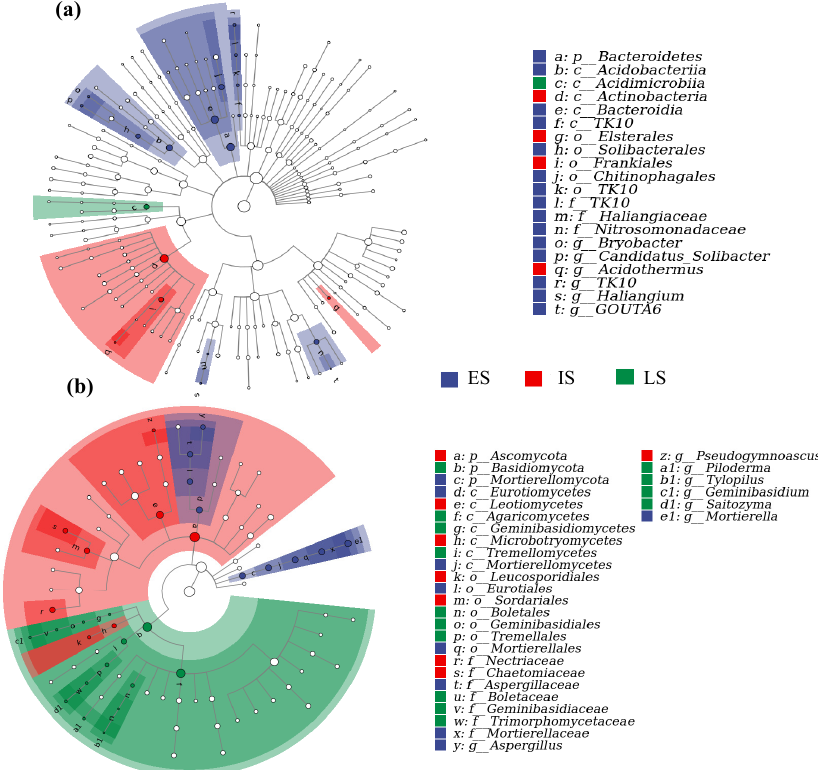
Figure 5. LDA Effect Size analysis of soil bacteria ( a ) and fungi ( b ) communities in different suc- cessional stages of broad-leaved Korean pine forest in Lesser Hinggan Mountains. ES: Early-stage; IS: Intermediate-stage; LS: Late-stage. We only provide LDA > 3.5 for bacterial community and LDA > 4 for fungal community.